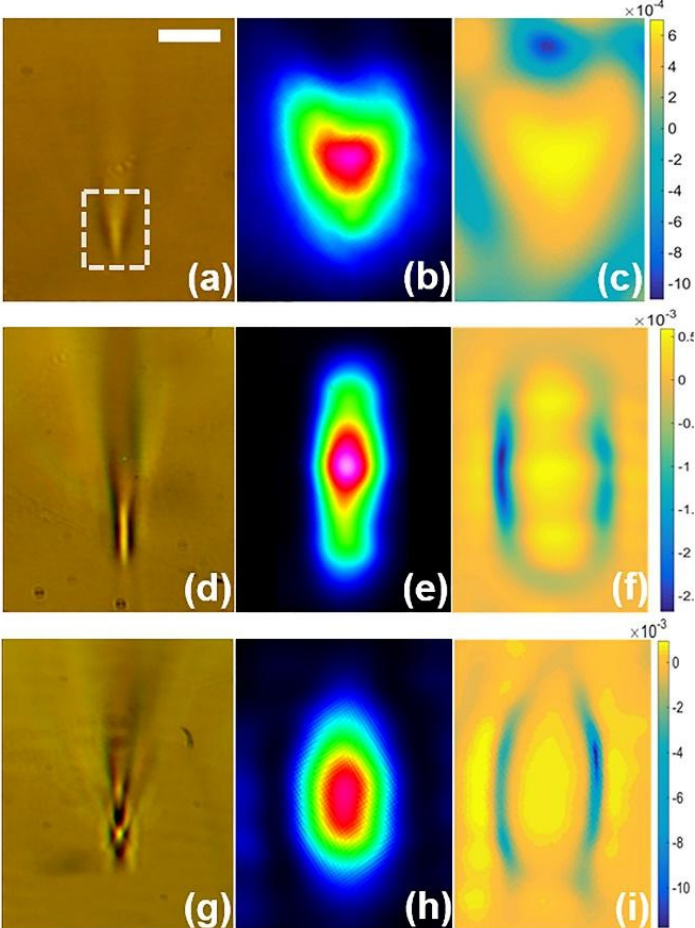
Figure 4. Cross-sectional view of a comet-shaped waveguide (0.6 µJ pulse energy, ~400 pulses) ( a ), rectangular-sectioned waveguide (0.6 µJ pulse energy, ~10 4 pulses) ( d ) and cylindrical-shaped waveguide (1.6 µJ pulse energy, ~600 pulses) ( g ) with corresponding measured near-field distribution ( b , e , h ) and estimated refractive index profile ( c , f , i ). Dash white squares indicate the laser radiation coupling position. Scaling bar equals 10 µm.